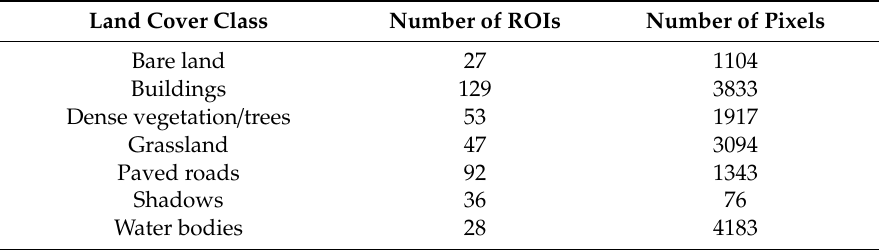
Table 1. Number of regions of interest (ROIs) and pixels per land cover class in the ground truth (GT)